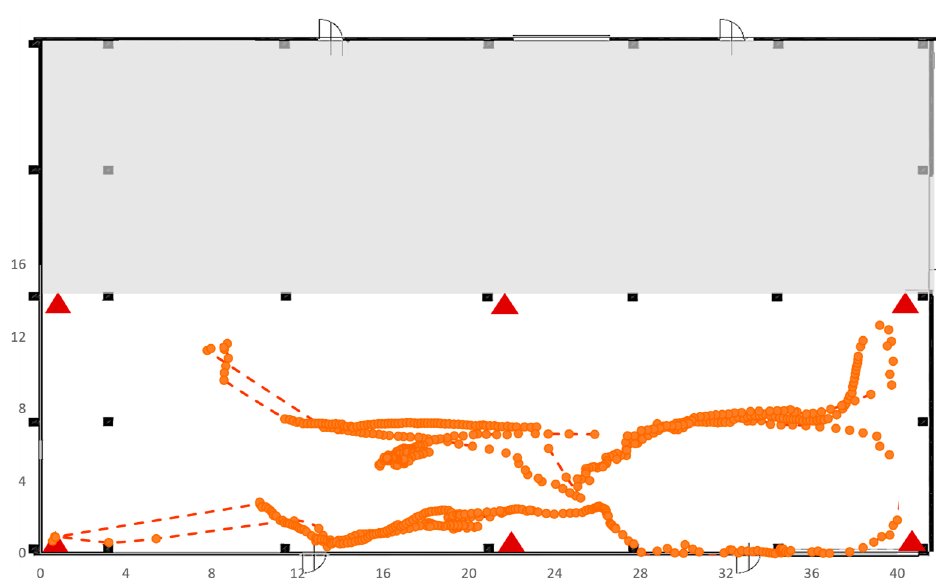
Figure 24. Results of Test 6; tag in the higher position.